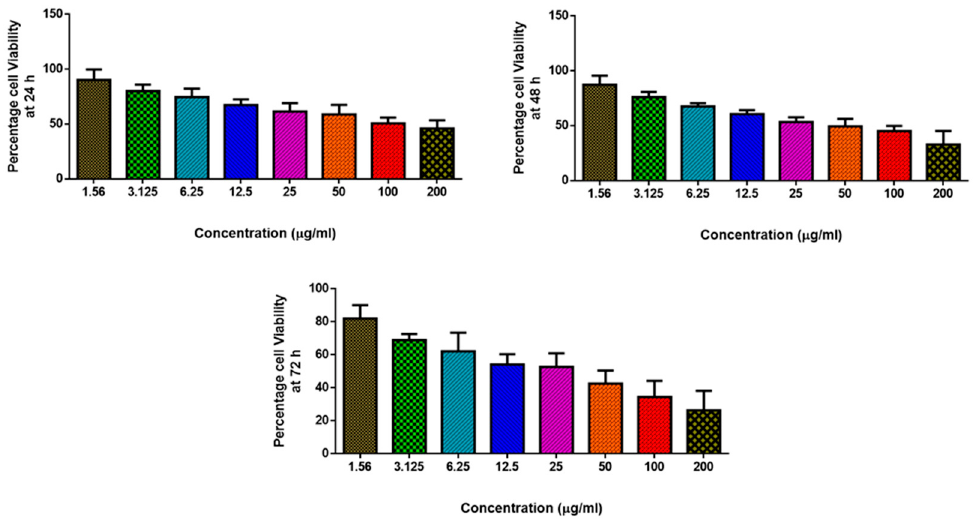
Figure 5. MgO-Chitosan-Pluronic F127-Escin NPs cause cytotoxicity in MDA-MB-231 cells. MDA-MB-231 cell lines from breast cancer were treated with